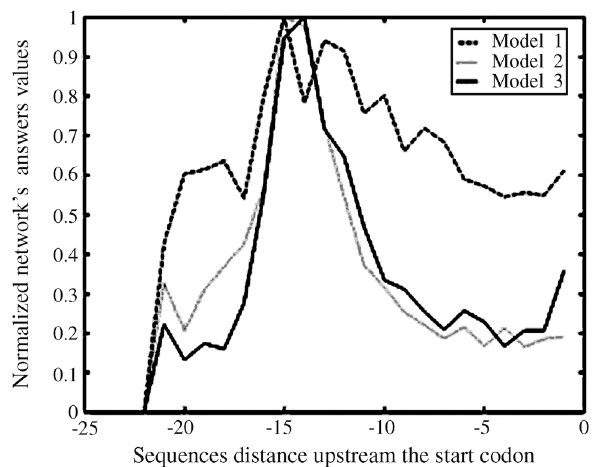
Figure 4 - Answer values from the networks for each position, for the three models.